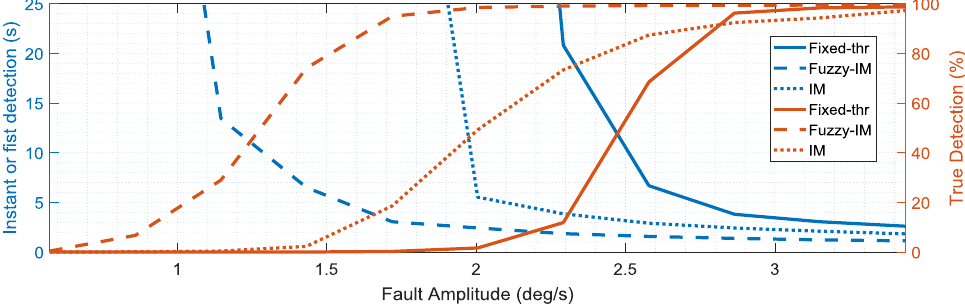
Figure 13. FD performance indexes for the p ( k ) sensor as function of the fault amplitude (mean values evaluated for the four validation flights). Sensors 2018 , 18 , x FOR PEER REVIEW